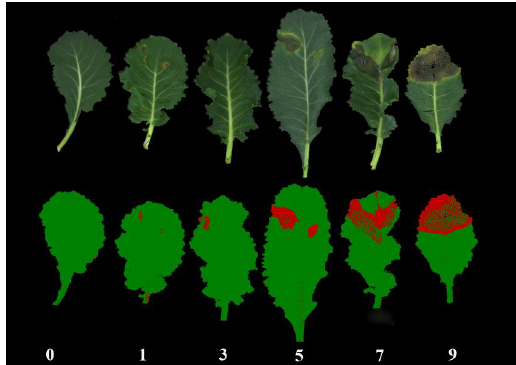
Figure 1. Grading evaluation of infected leaves according to a six-point scale from zero to nine based on the relative lesion size and severity. (Upper row, photos under ordinary brightfield lighting; bottom row, photos analyzed by the plant phenotype measurement system (PPMS). Table 1. Investigation of Xanthomonas campestris pv. campestris race 4 ( Xcc 4) Resistance of Different B. oleracea Accessions.